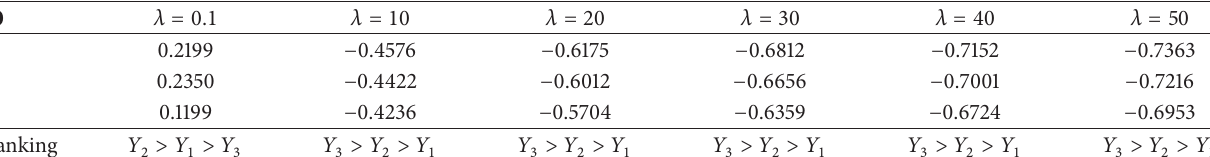
Table 10: Score values obtained by the GIVIHFWG and GIVIHFHG operators and the rankings of alternatives.